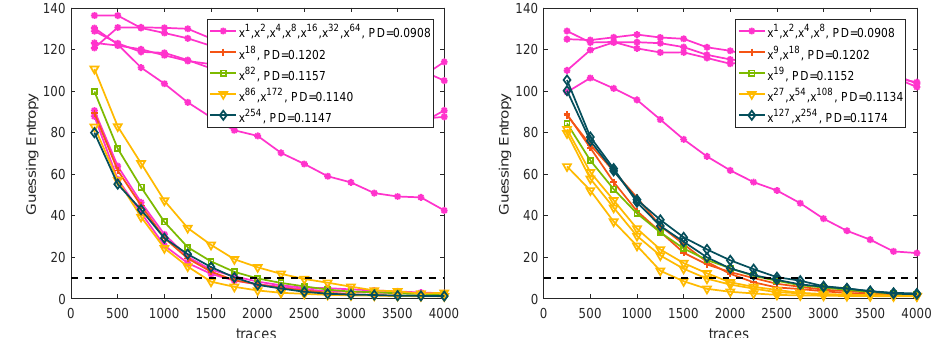
Figure 10: The results of second-order CEMA toward each monomial computation in four different masked addition chain